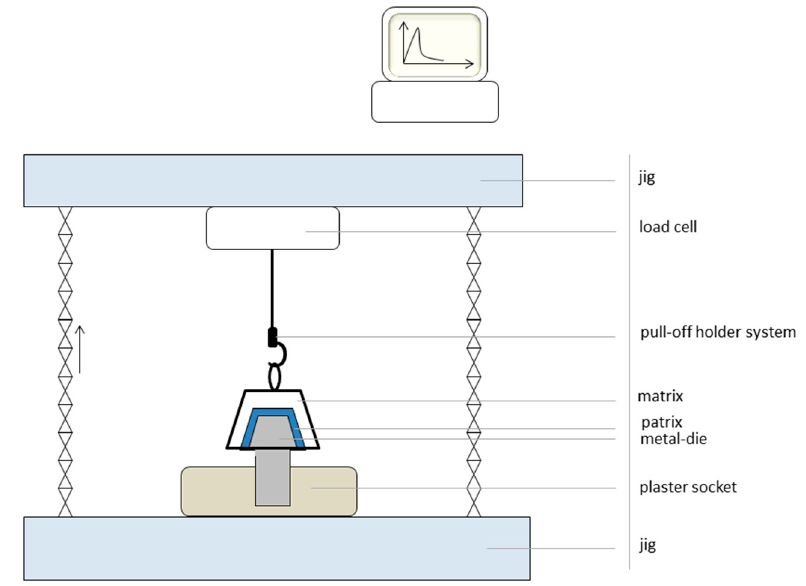
Figure 3. Test design.